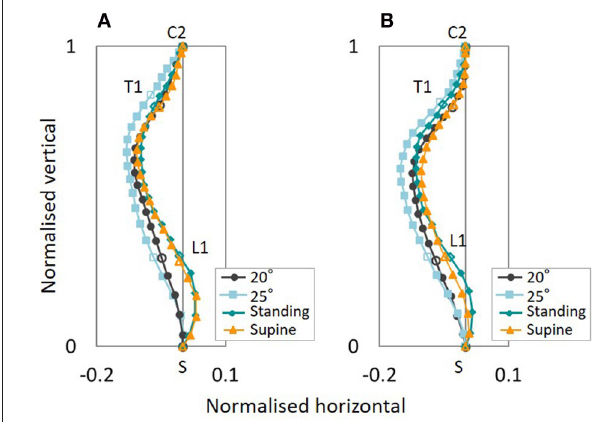
FIGURE 8 | Average gender-specific spinal alignments for the standing and supine postures, comparing the automotive seating posture with the 20 ◦ and 25 ◦ seat back angle. (A) Female, (B) Male.